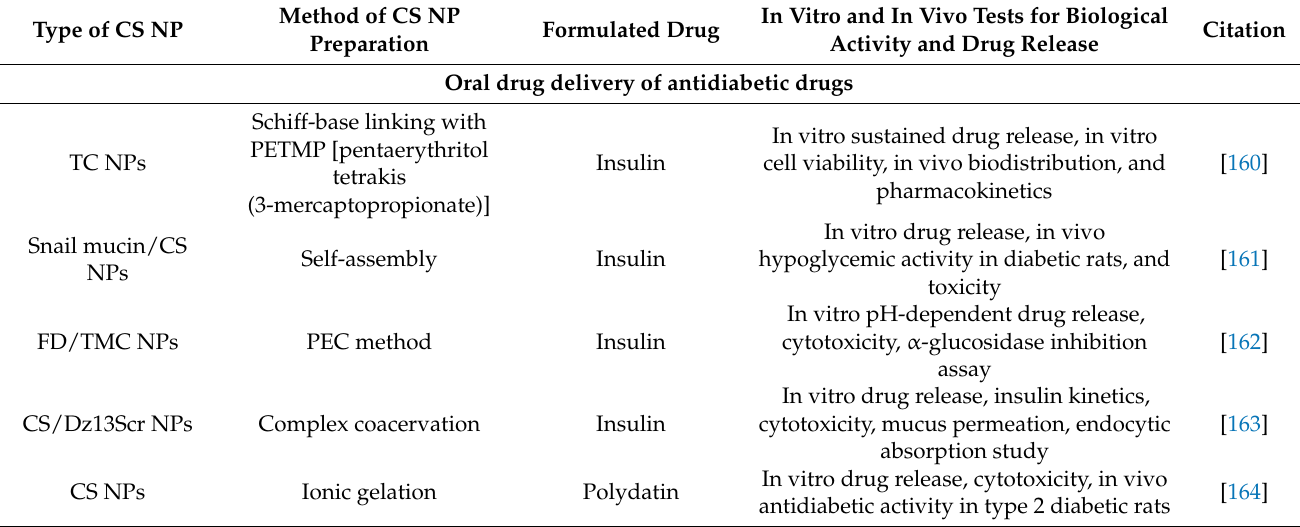
Table 3. Current application examples of chitosan nanoparticles and nanocomposites in drug delivery. Type of CS